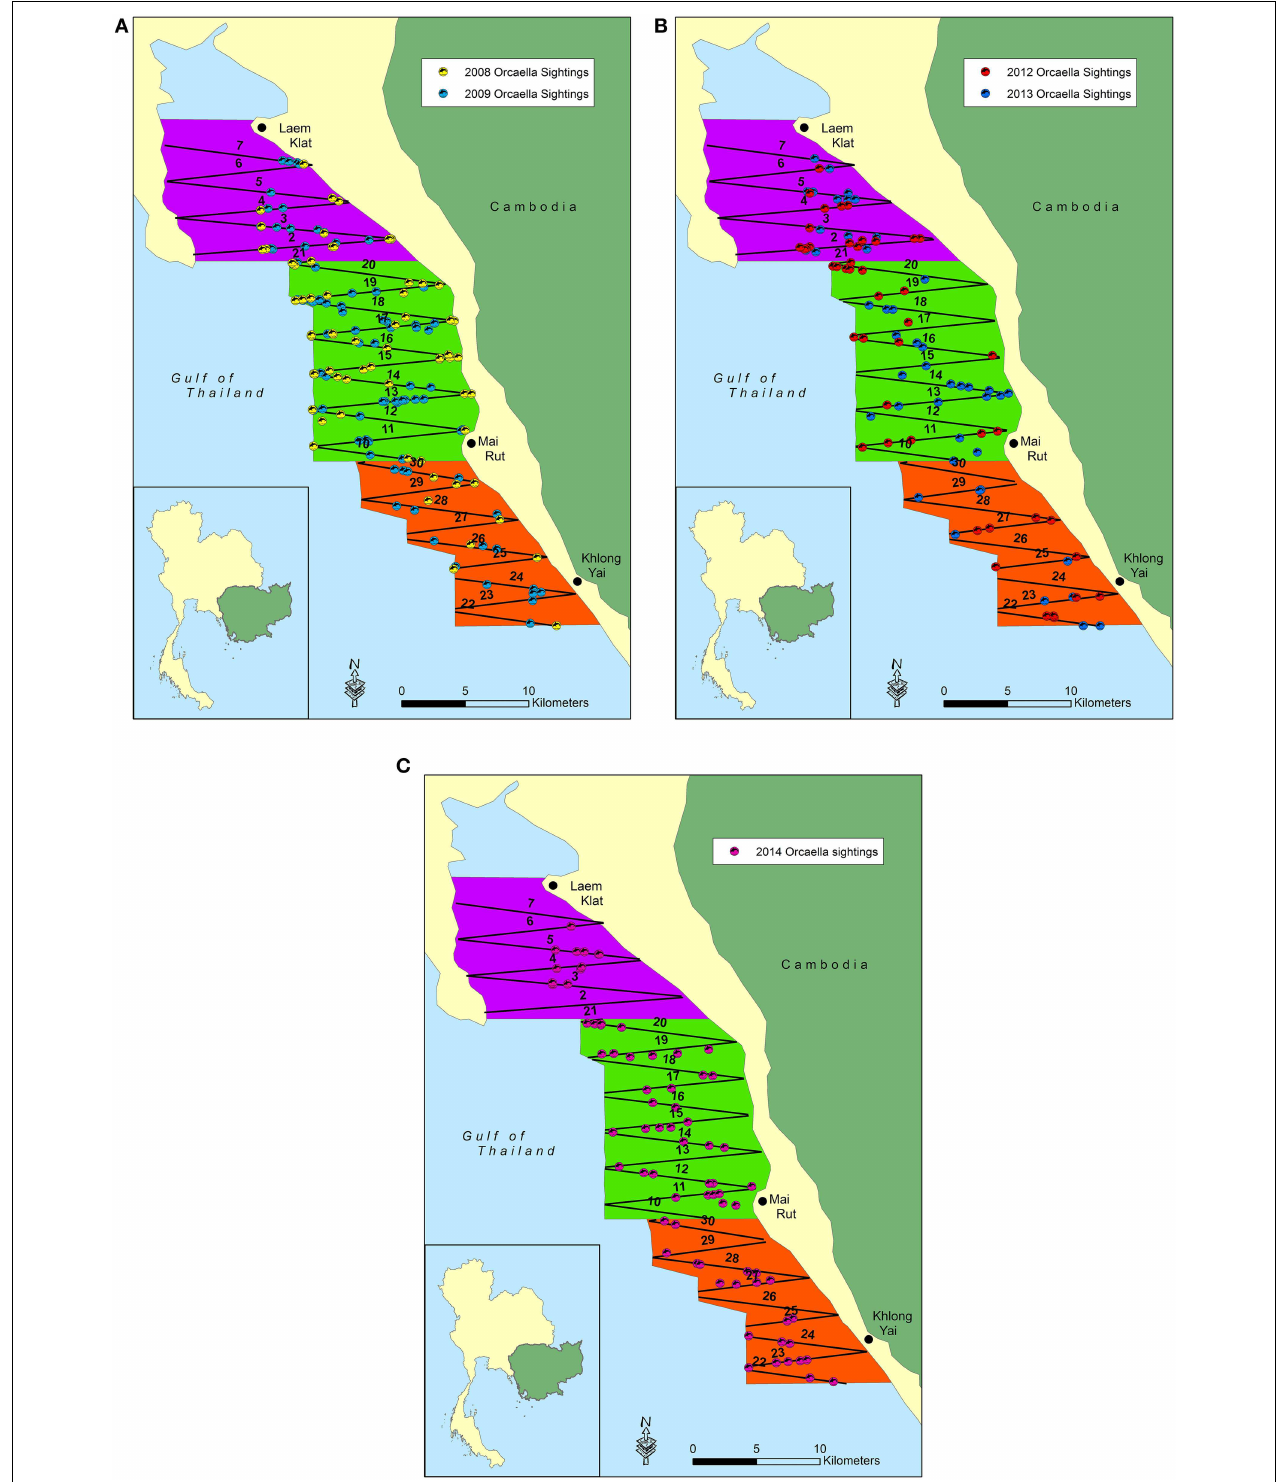
FIGURE 2 | (A) All on-effort sightings of Orcaella brevirostris in 2008 and 2009 surveys along the coast of Trat Province, on the eastern Gulf coast of Thailand. The purple area is the north strata closer to the shallow Bay. The green area is the shallow middle strata near several river mouths. The orange area is the south strata, a deeper area closer to the major fishing port of Khlong Yai. (B) All on-effort sightings of Orcaella brevirostris in 2012 and 2013 surveys along the coast of Trat Province, on the eastern Gulf coast of Thailand. (C) All on-effort sightings of Orcaella brevirostris in 2014 surveys along the coast of Trat Province, on the eastern Gulf coast of